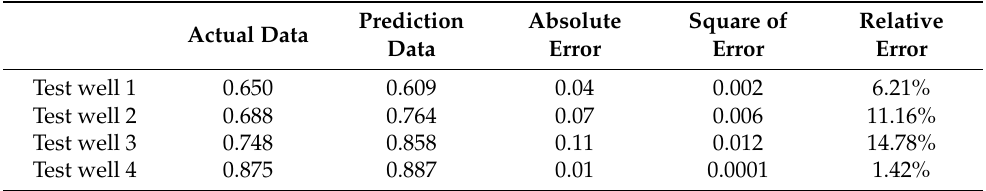
Table 11. Cumulative production predictive performance results for four test wells.